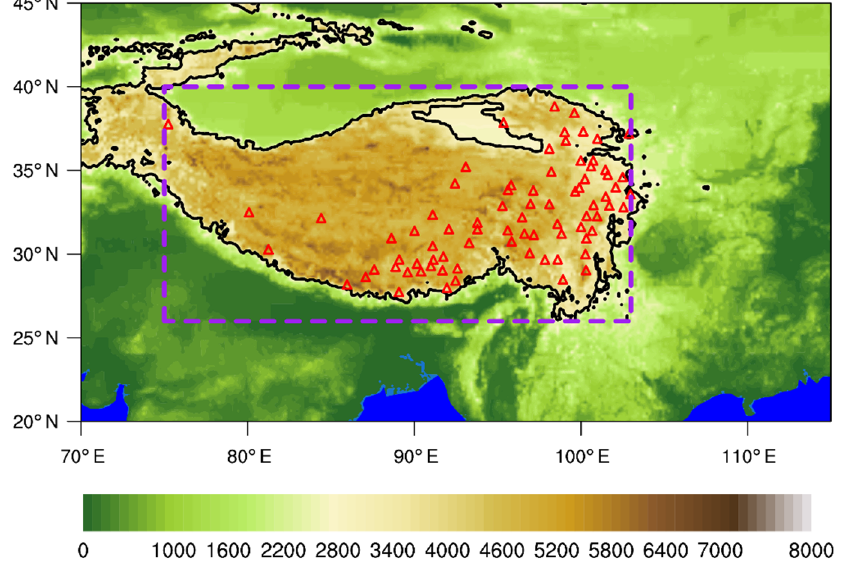
Figure 1. Terrain height of the TP (shading; units: m). TP is defined as the region within 26–40° N and 75–103° E (purple dashed rectangle) where the terrain height exceeds 3000 m (black line). The red triangles show the location of automatic weather stations on the TP.